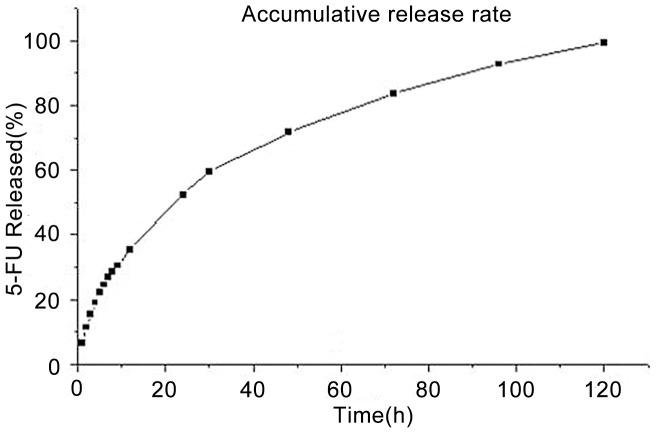
In vitro pharmacokinetics test were performed in PBS which showed that 5-FU-NPs may release maintain for about 5 days evenly with accumulating release amount up to 99.2%. P<0.05.